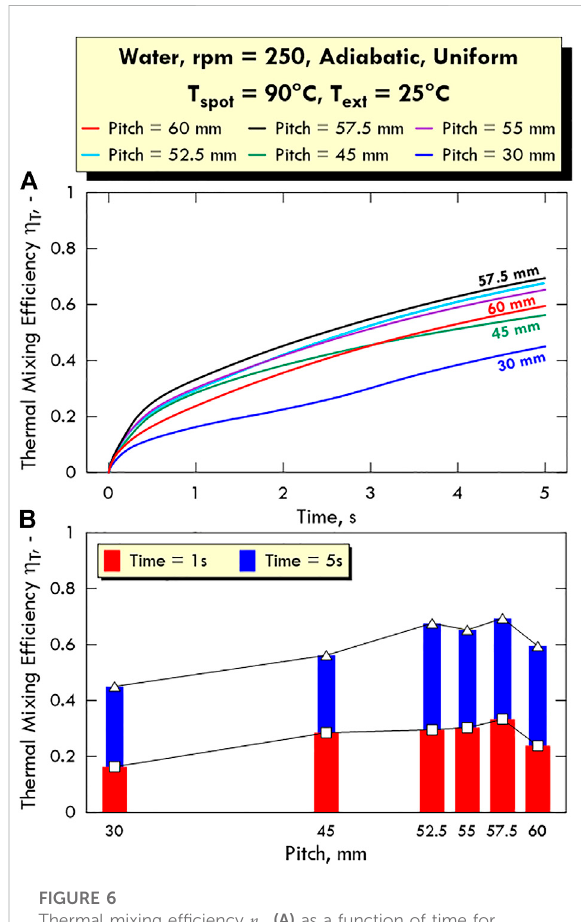
FIGURE 6 Thermal mixing ef fi ciency η T (A) as a function of time for differentvalues ofpitch and (B) as afunction of pitch at 1 and 5 sin adiabatic conditions in uniform con fi guration. Fluid: water, T spot = 90 ° C, T ext = 25 °